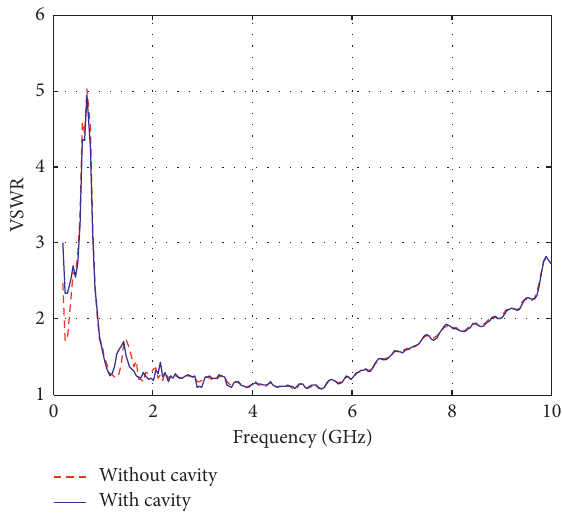
Figure 22: Measured VSWR of the antenna prototypes with and without back